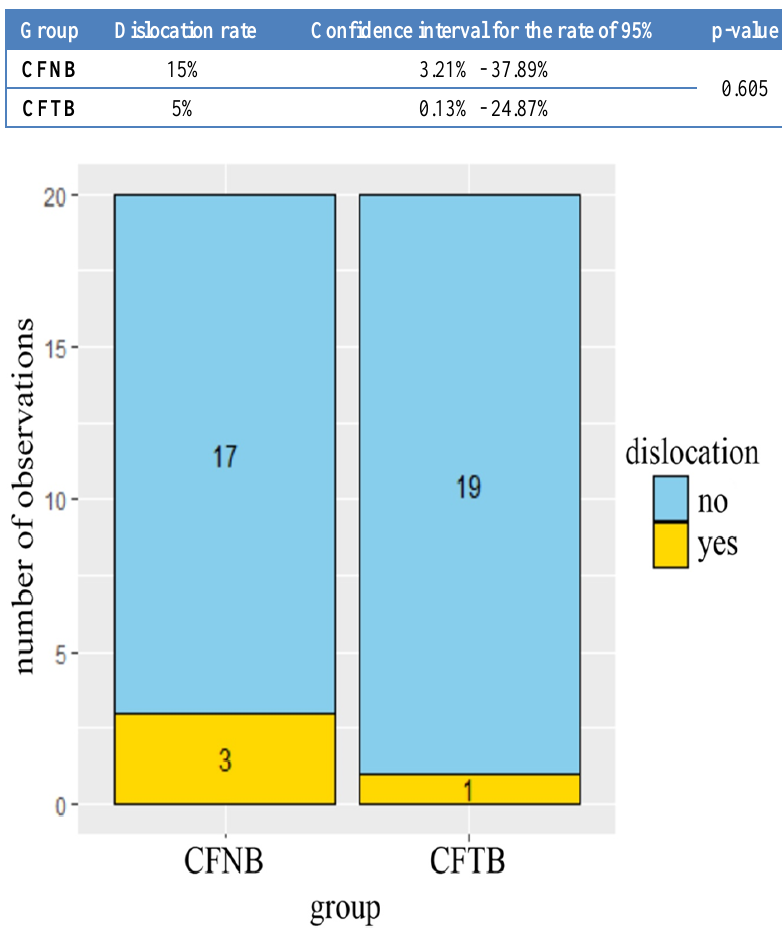
ASA p = 1 After 24 h following the placement of the catheter, the distance between the SMC orifice and the femoral nerve in Group 1 was 0.83 cm (SD = ± 0.87). In Group 2, the distance between the catheter orifice and the saphenous nerve after 24 h was 0.43 cm (SD = ± 0.67).